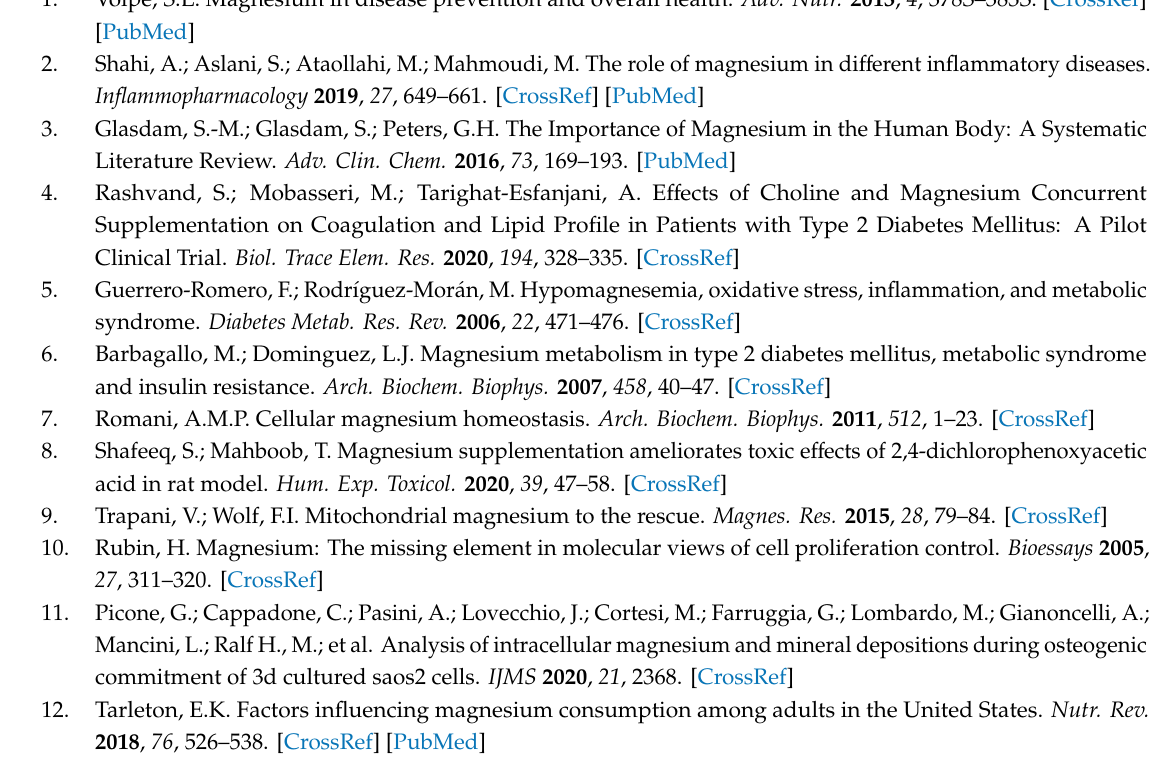
Supplemental Table S1: Quantitative 14-item questionnaire for Adherence to Mediterranean diet; Supplemental Figure S1: Urinary magnesium concentration depending on the age group in the whole population; Supplemental Table S2: Mediterranean diet adherence components and plasma magnesium concentrations depending on the item